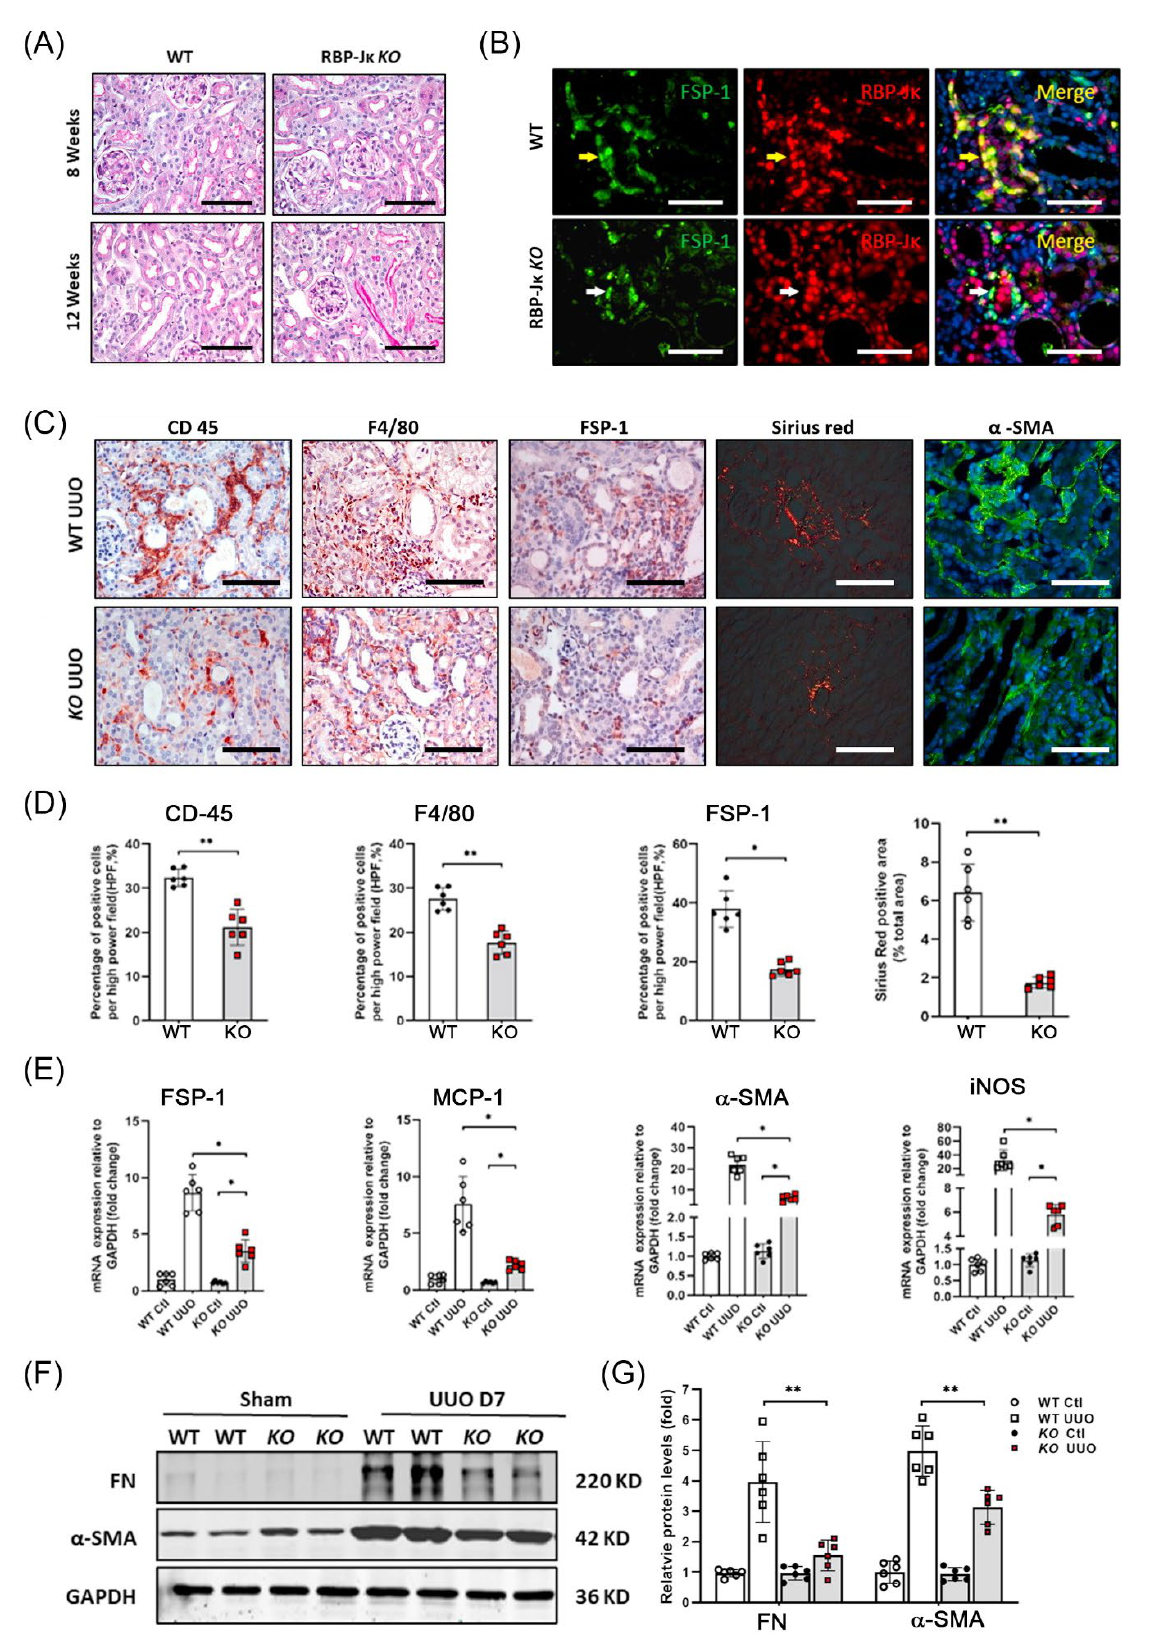
Figure 5. Loss of RBP-J κ -dependent Notch signaling in FSP-1 + cells ameliorates UUO-induced tubulointerstitial fibrosis. ( A ). PAS staining of kidneys from WT and FSP-1 RBP- Jκ KO control mice at